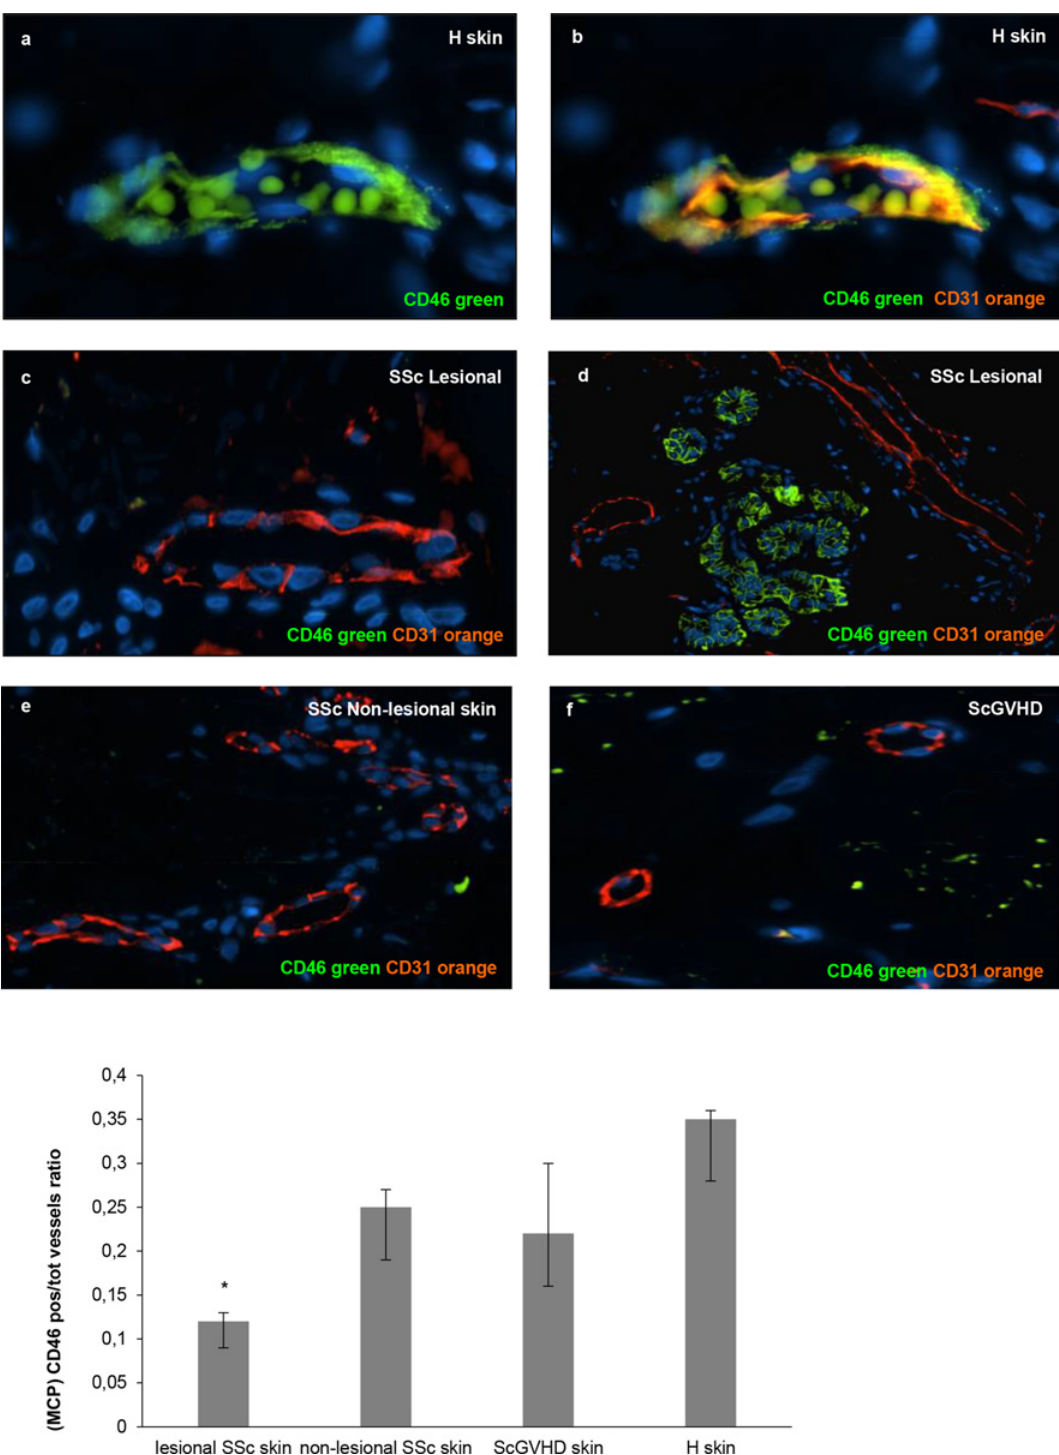
Fig 3. The local complement regulator MCP (CD46) is reduced on vascular endothelial cells of SSc skin biopsies. Skin sections from 8 SSc patients (4 lesional SSc skin and 4 non-lesional SSc skin), 12 controls (8 healthy subjects and 4 ScGVHD patients) were immunostained with anti-CD46 (green) specific antibody. Anti-CD31 antibody (orange) was used as a marker of endothelial cells. Data of the analysed fields ( n = 20 for each slide) are expressed as ratio between MCP (CD46) positive vessels and total number of vessels.